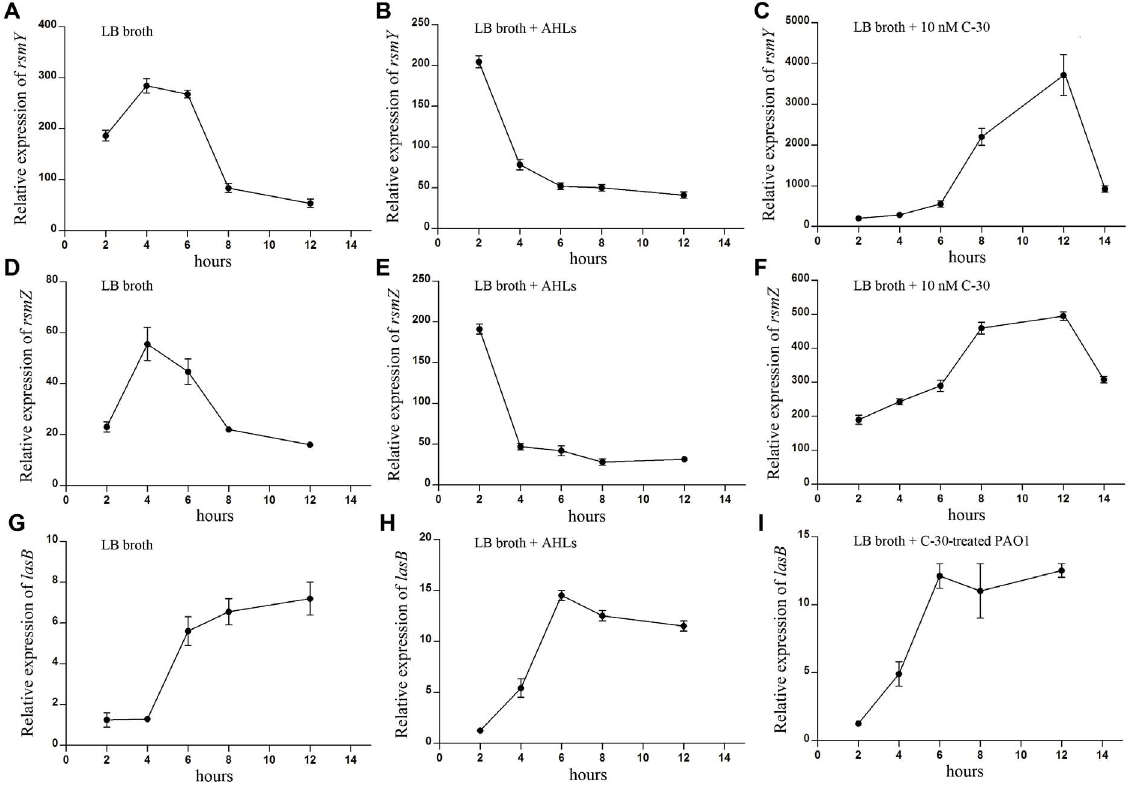
Figure 6. High levels of rsmY and rsmZ expression could cause an accelerated induction of cooperation. Time-dependent expression of rsmY and rsmZ of WT PAO1 was detected in LB broth (A and D), LB broth containing 20 m M 3O-C12-HSL and 20 m M C4-HSL (B and E), and LB broth containing 50 m M furanone C-30 (C and F). Time-dependent expression of lasB of same amounts WT PAO1 in LB broth (G) and LB broth containing 20 m M 3O-C12-HSL and 20 m M C4-HSL (H), and furanone C-30-treated PAO1 in LB broth (I).